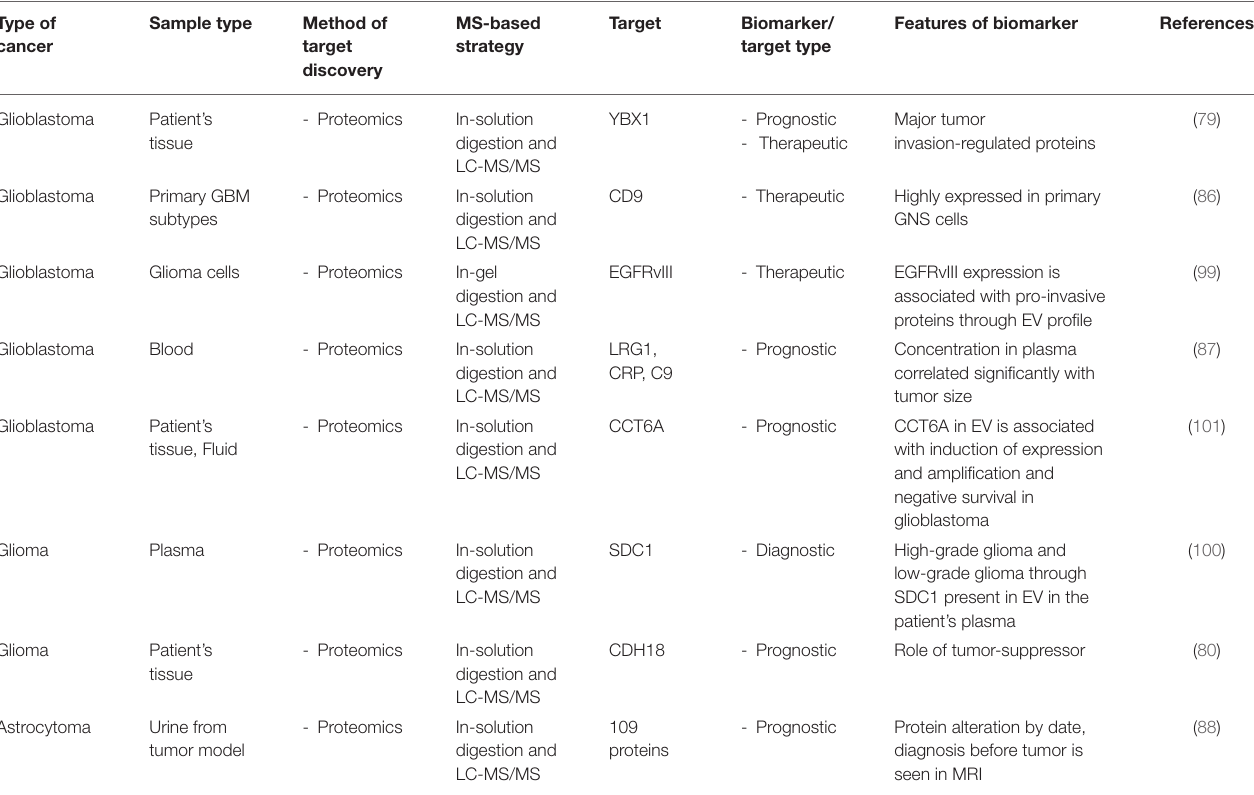
TABLE 4 | List of molecular targets in brain cancer identified with proteomics